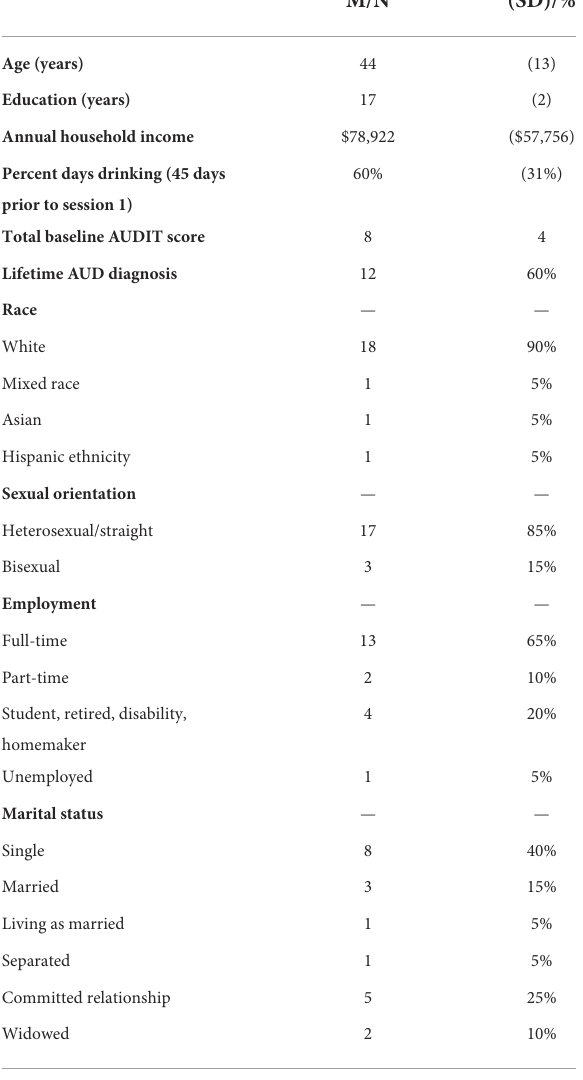
TABLE 1 Participant demographics and descriptive statistics ( n =